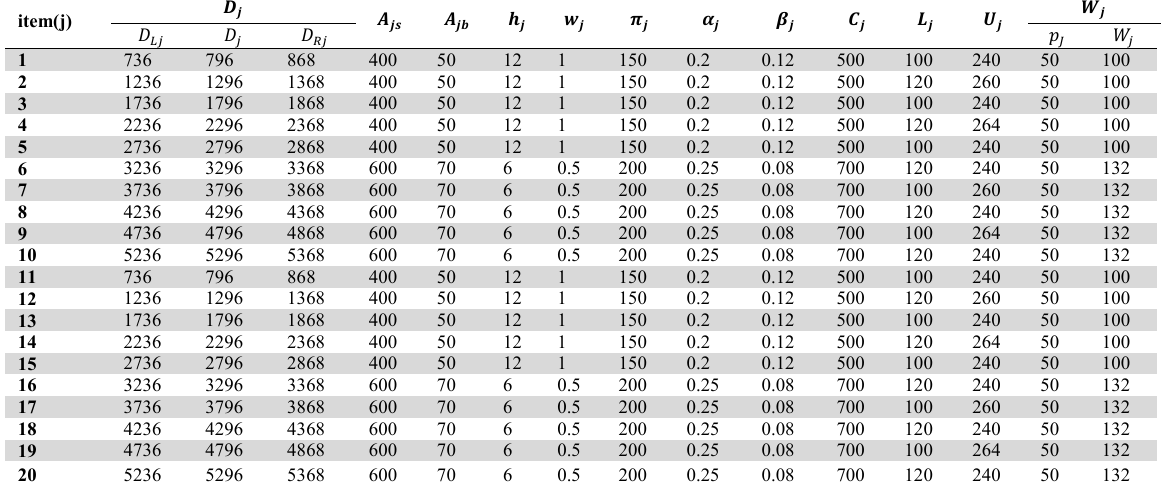
The crisp total VMI cost obtained by the algorithms Problem no.